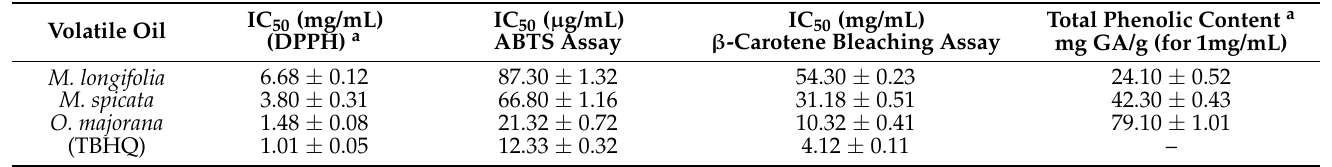
Table 2. Antioxidant activity of essential oils for M. longifolia , M. spicata , and O. majorana cultivated in Madinah in comparison to the synthetic antioxidant TBHQ. IC 50 (mg/mL) Volatile Oil (DPPH)